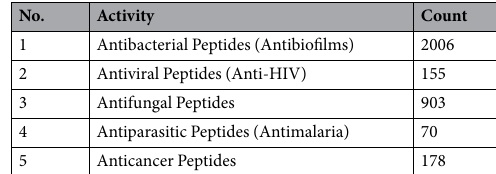
Table 3. Number of sequences for different activities in the filtered